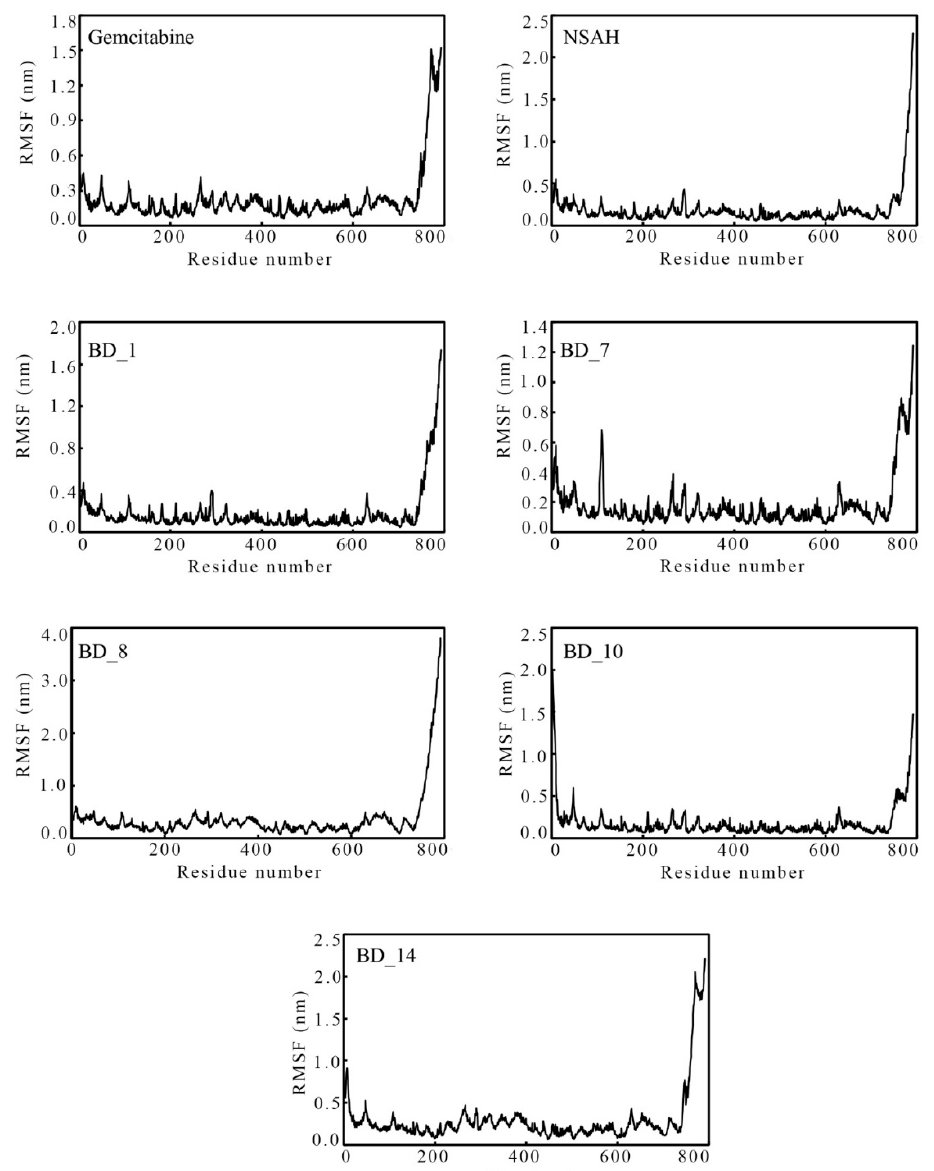
Figure 8. RMSF of individual hRRM1 amino acids bound with gemcitabine, NSAH, BD_1, BD_7, BD_8, BD_10, and BD_14.